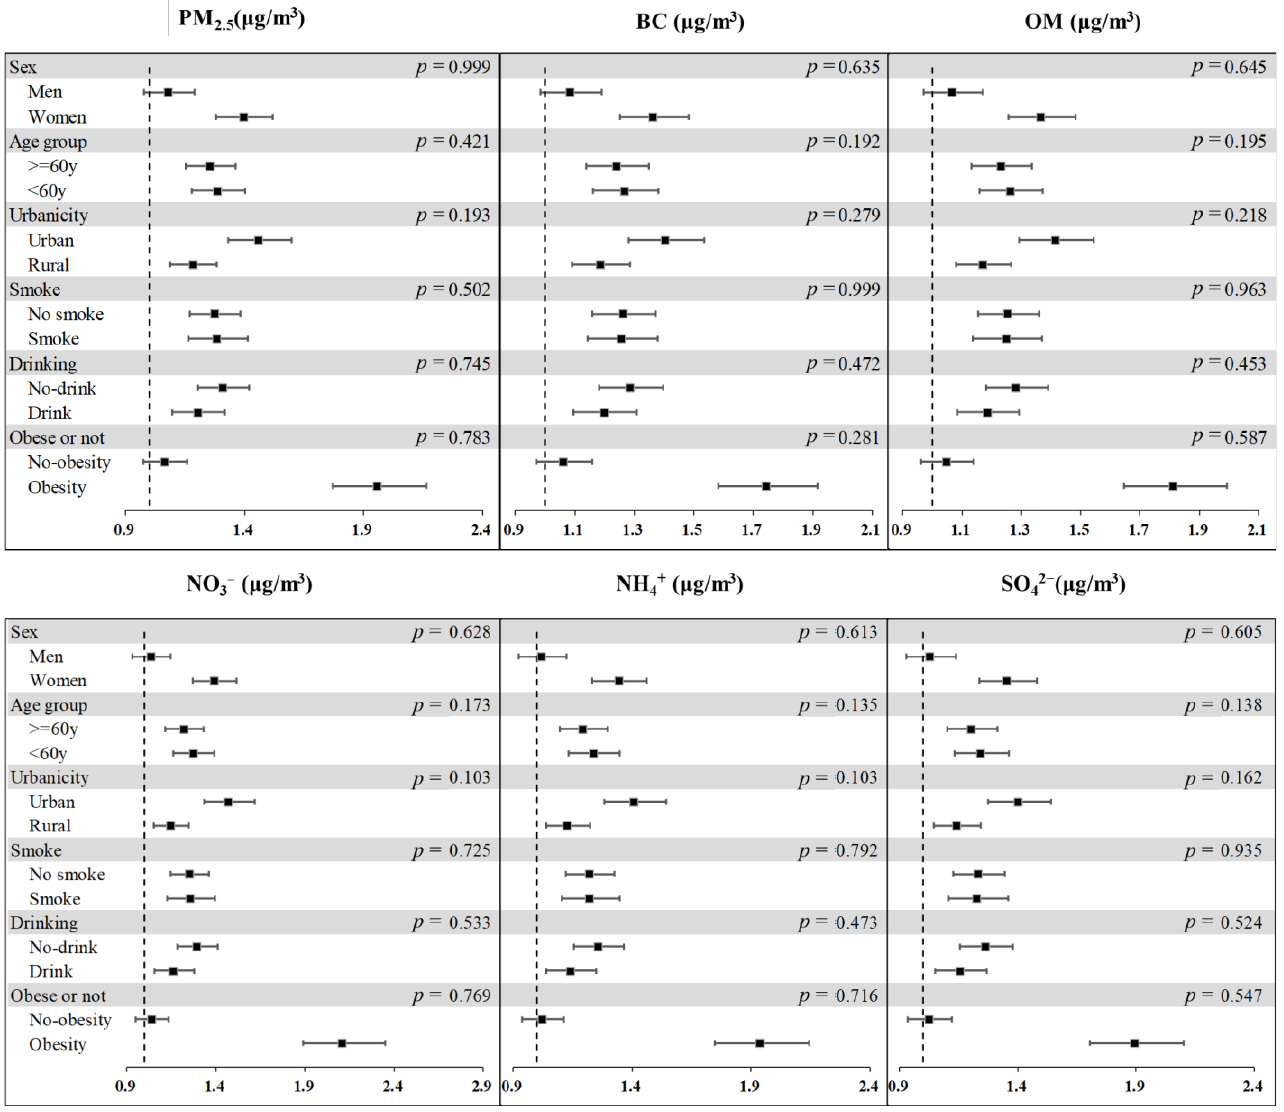
Figure 2. Odds ratios of metabolic syndrome (MetS) associated with an IQR incremental change in 1-year average PM 2.5 and its constitution, classified by different subgroups. The bars show main effect estimates and 95% confidence intervals. The model was the fully adjusted model adjusted for age, sex, urbanicity, educational level, marriage status, smoking, drinking, cooking fuel type, heat- ing fuel type, and physical activity. Abbreviations: BC: Black Carbon; NH 4+ : Ammonium; NO 3 − : Ni- trate; OM: organic matter; SO 4 2 − : Sulfate. p value refers to the difference of the estimations between different subgroups .